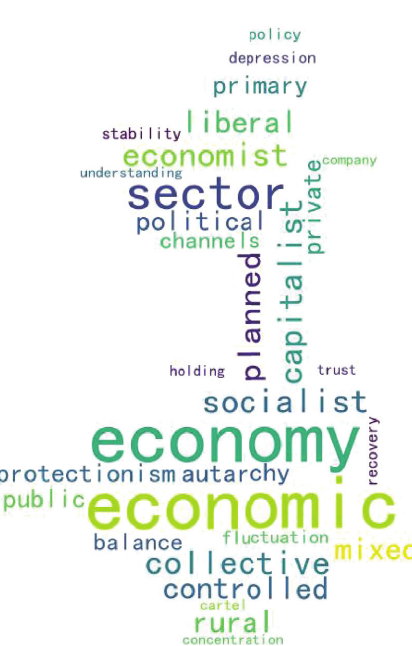
Figure 8: Business English word cloud analysis.